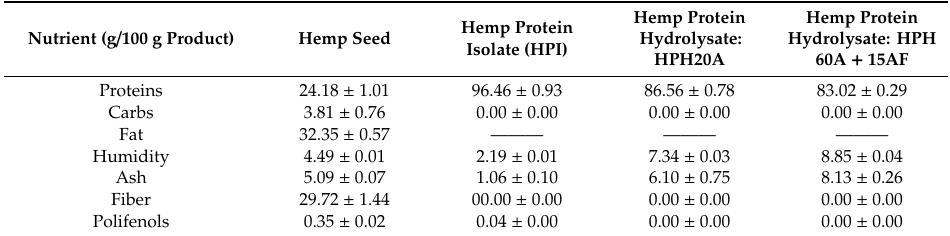
Table A1. Chemical composition of hemp seed, HPI, HPH20A and HPH60A15F. Data, expressed as percentage in dry basis, are mean ± standard deviation of triplicates [9].